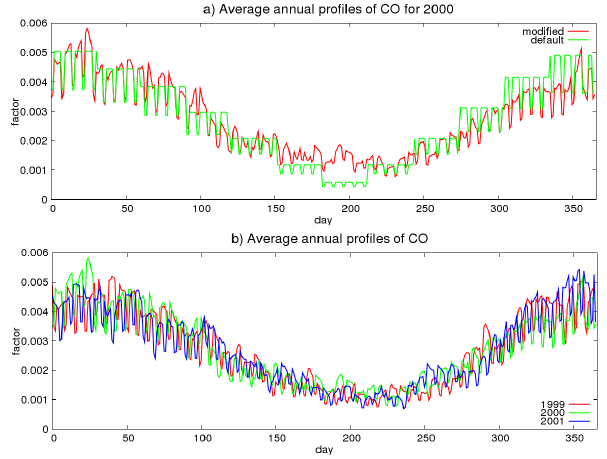
Fig. 3. All values are averaged over the whole 54 × 54km 2 domain (Fig. 2) for the year 2000. (a) Comparison of temperature dependent temporal profiles SMOKE default with the modified version. (b) Inter annual comparison of temperature dependent CO temporal